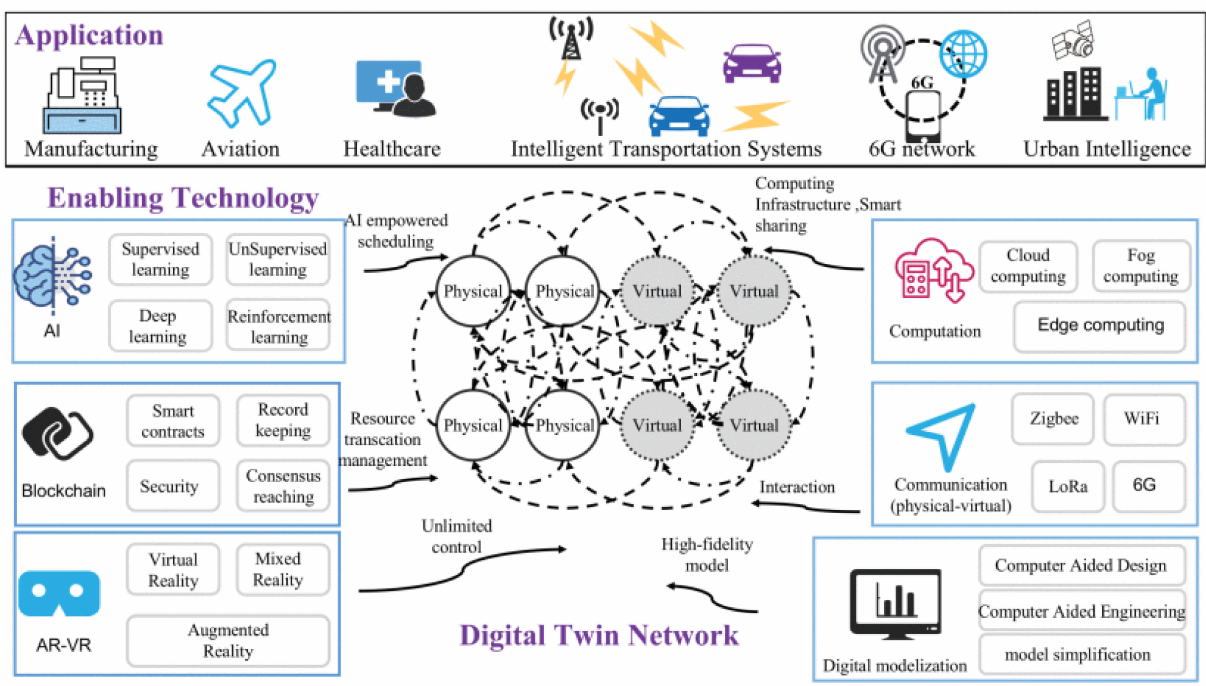
Figure 8. Applications of digital twin networks